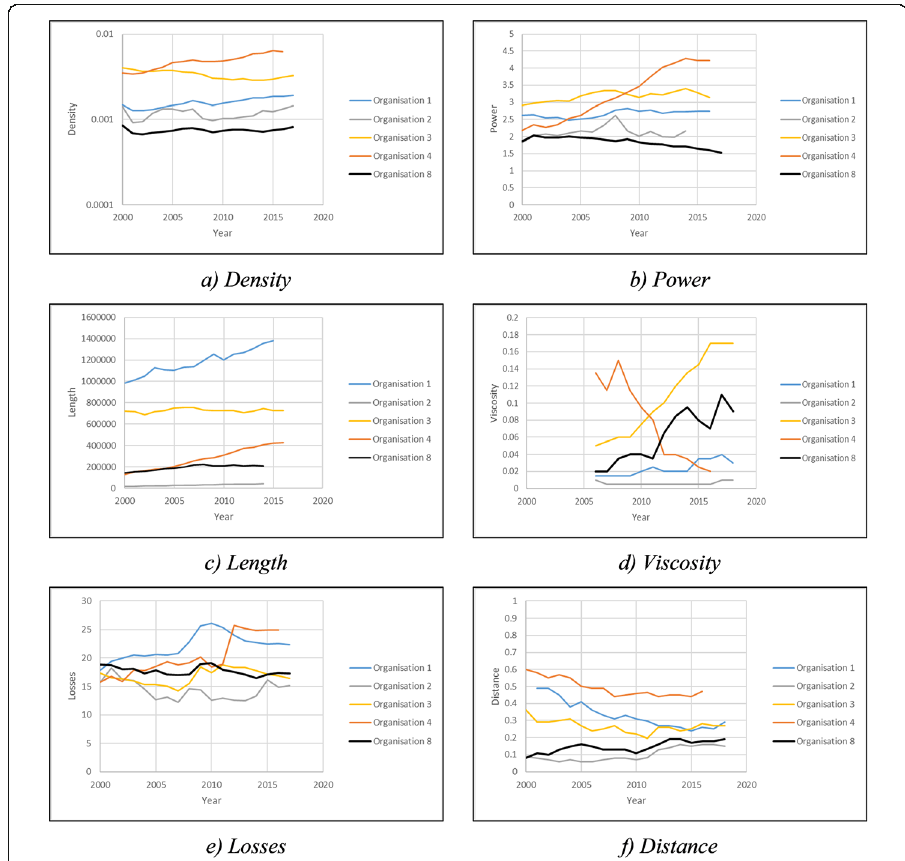
Fig. 17 R i parameter values per selected